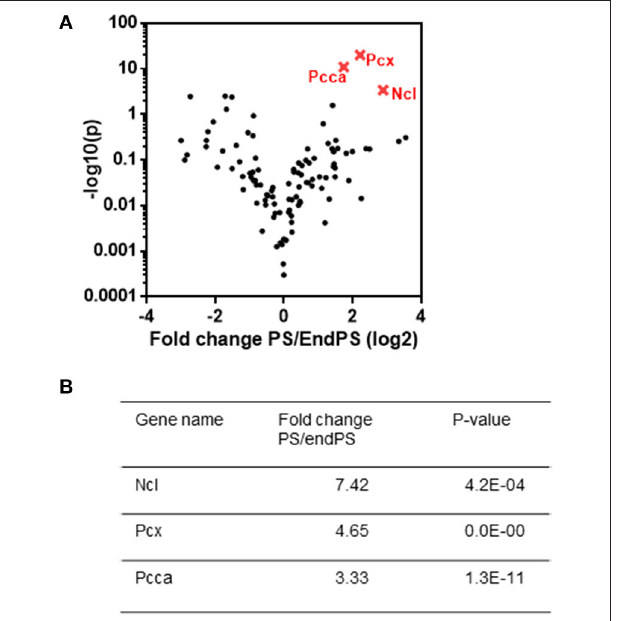
FIGURE 3 | Crosslinking and proteomic analysis of proteins responsible for PS binding. (A) Comparison of PS and endPS UV + sample interactome by a volcano plot analysis. (B) List of three statistically differentially expressed proteins (nucleolin (NCL), pyruvate carboxylase (PCX), and propionyl-CoA carboxylase subunit alpha (PCCA), which are found to be explicitly enriched in PS interactome as compared to endPS interactome. The most significantly enriched partners of the 2OMePS analog were identified by a volcano